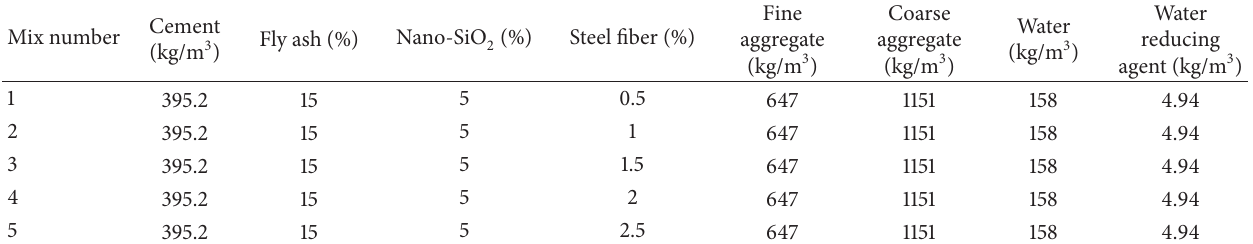
Table 5: Mix proportions of the concrete composites.